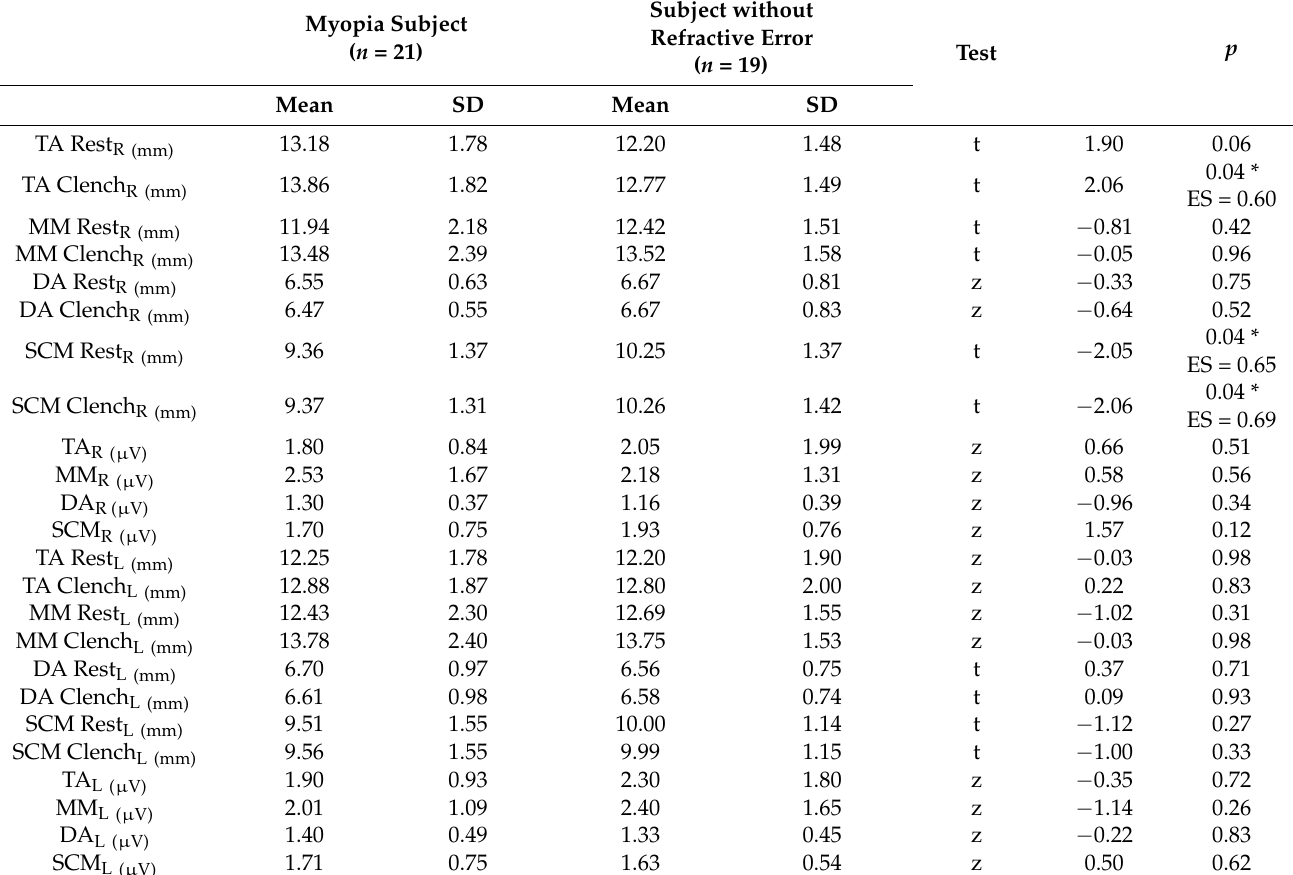
Table 2. Comparison of masticatory and cervical muscle thickness and activity between